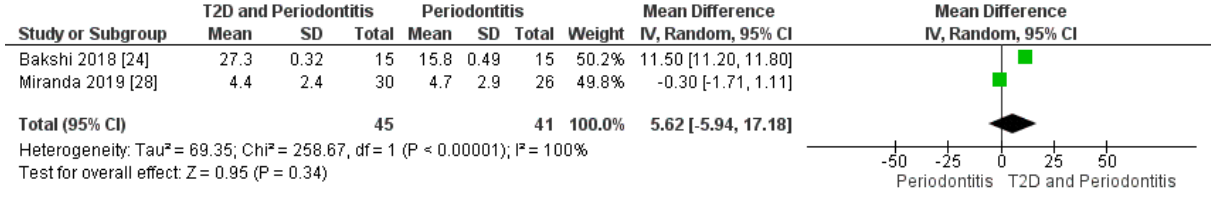
Figure 4. Forest plot for TNF- α levels in the plasma of the periodontitis and the diabetes plus periodontitis groups.